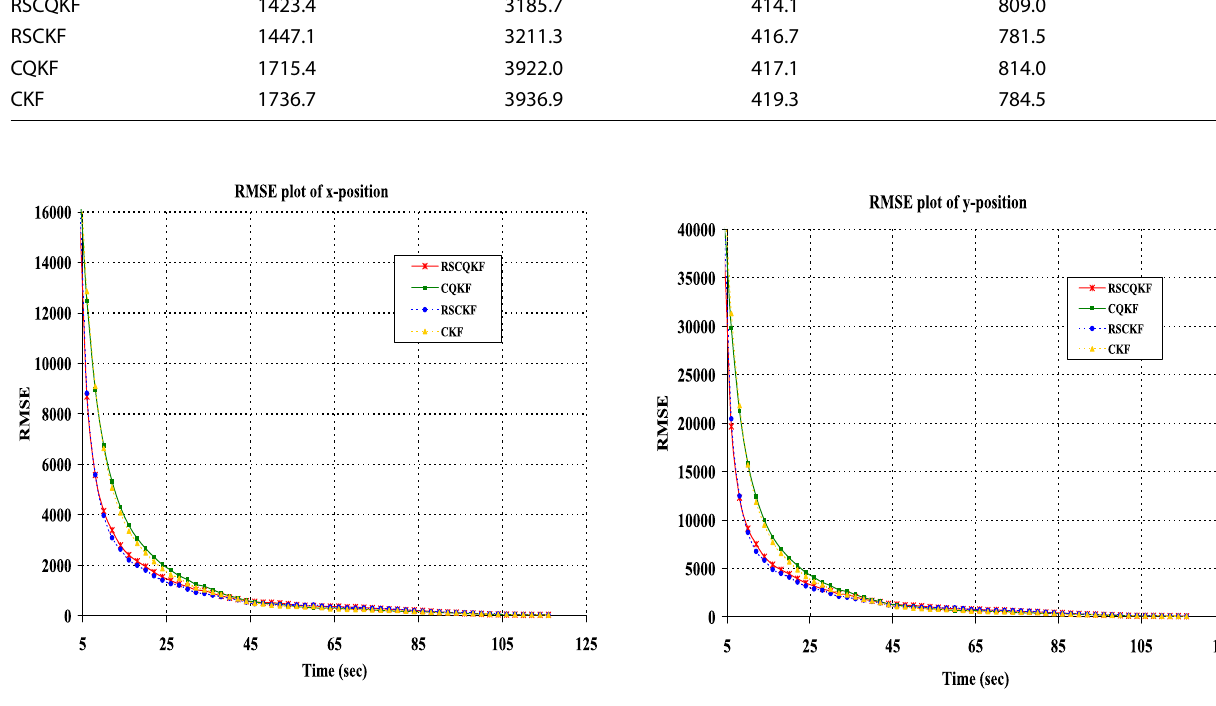
Fig. 7 RMSE plot of RSCQKF, RSCKF, CQKF and CKF for 𝐲 -position (in km) of the